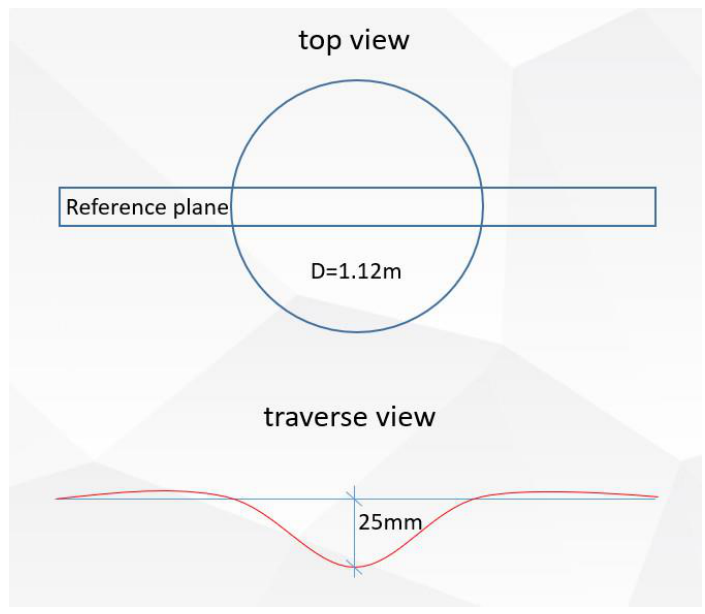
Figure 13. Theoretical calculation of evenness indicator (EI) threshold.